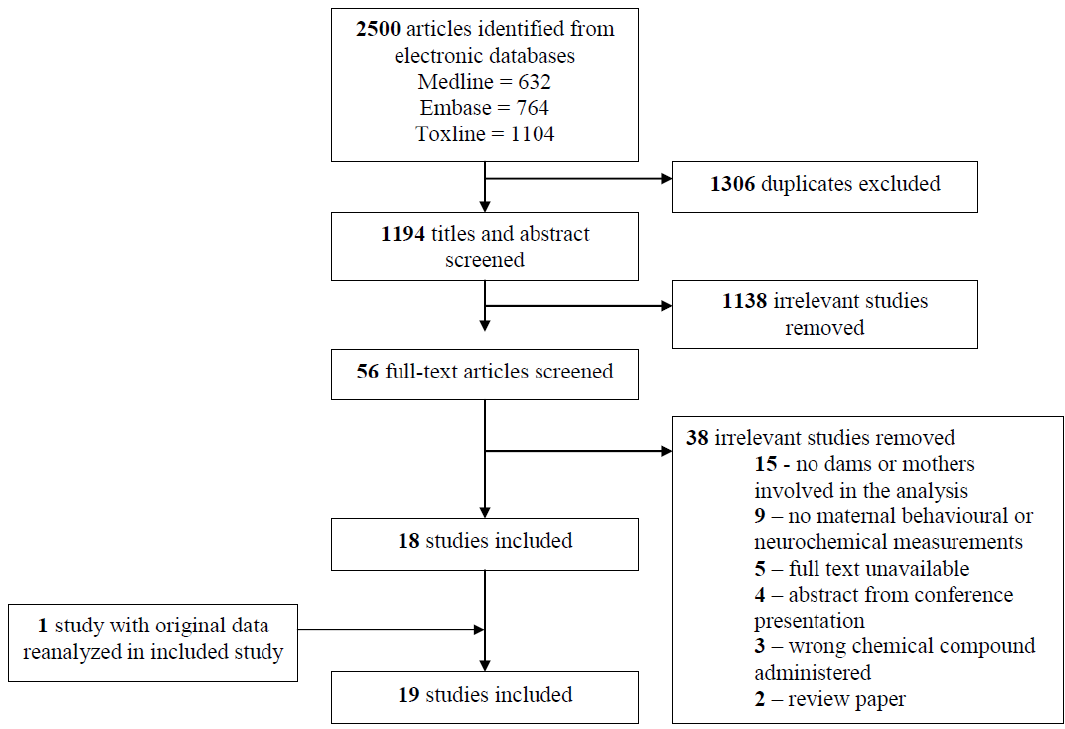
Figure 1. Flow diagram for the scoping review study selection process.